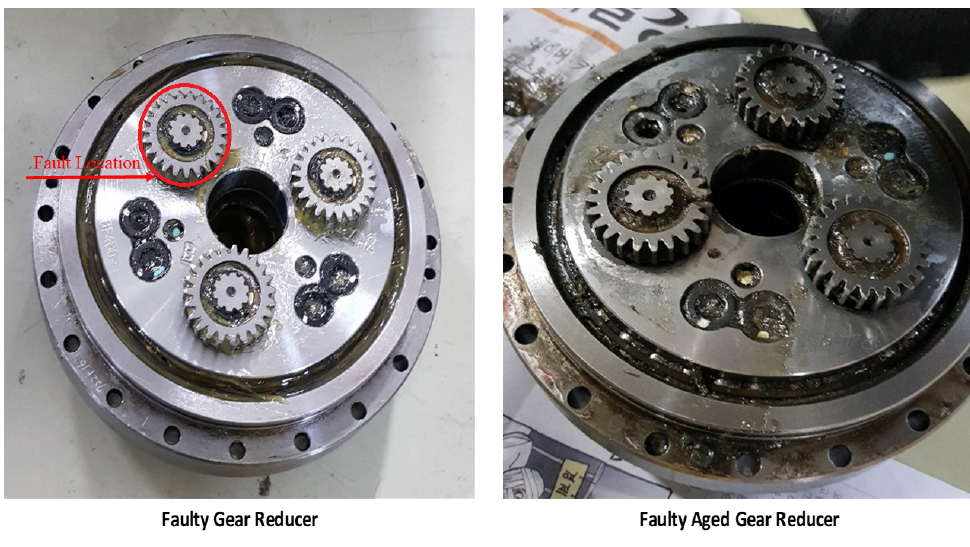
Figure 7. RV reducer gear for Hyundai Robot: faulty and faulty